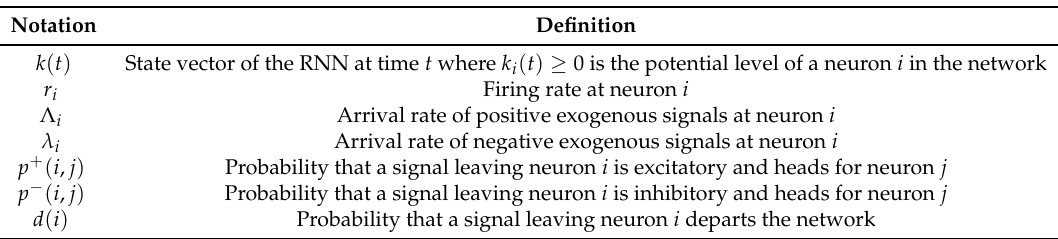
Table 1. Notation for the RNN